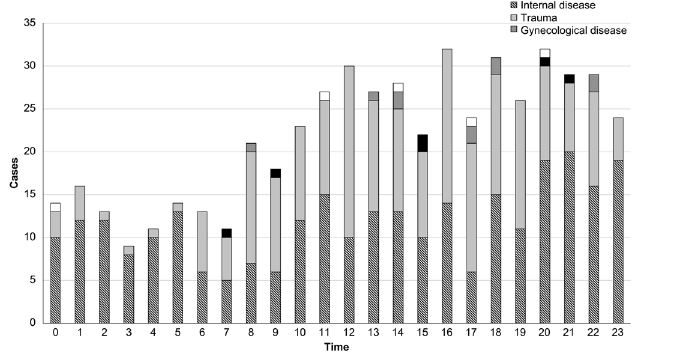
Figure 3. Frequency of Ambulance Dispatch by Time.